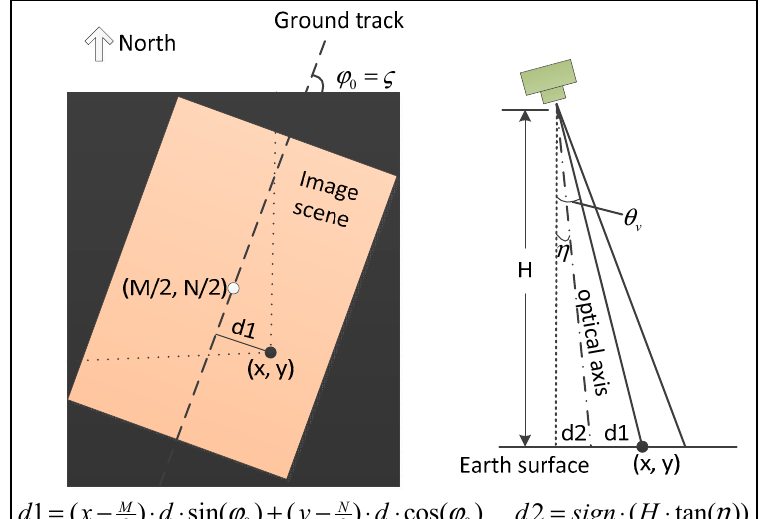
Figure 3. Diagram of the rough estimation of VZ of certain pixel position.